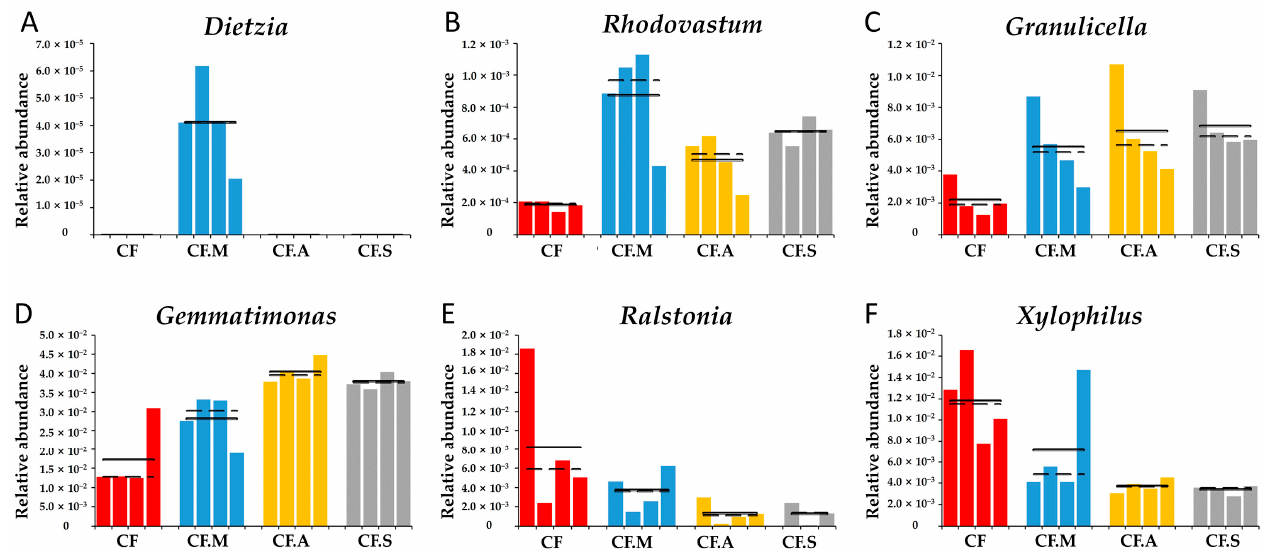
Figure 9. The relative abundance of Dietzia ( A ), Rhodovastum ( B ), Granulicella ( C ), Gemmatimonas ( D ), Ralstonia ( E ), and Xylophilus ( F ) in the rhizosphere microbiome based on results of LefSe analysis. Solid and dashed lines indicated the means and medians, respectively.